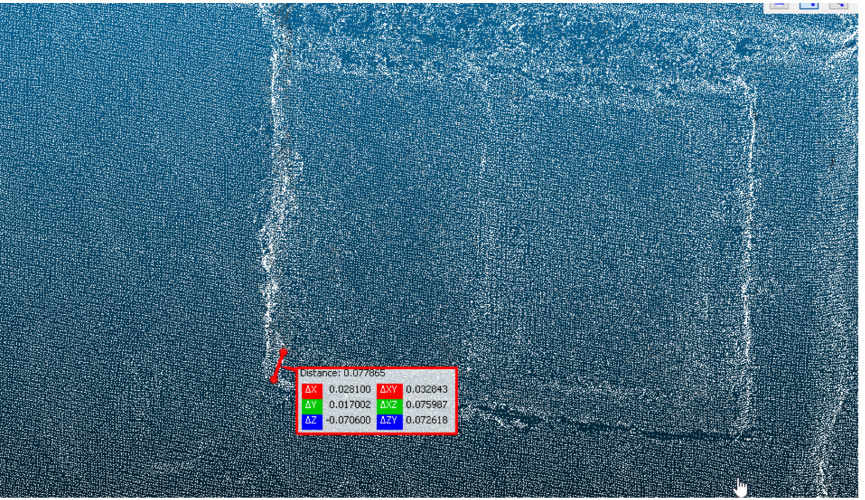
Figure 9. The distance between the “wide” point cloud and the acquired “wide + zoom”, on the example of a support at the entrance to the